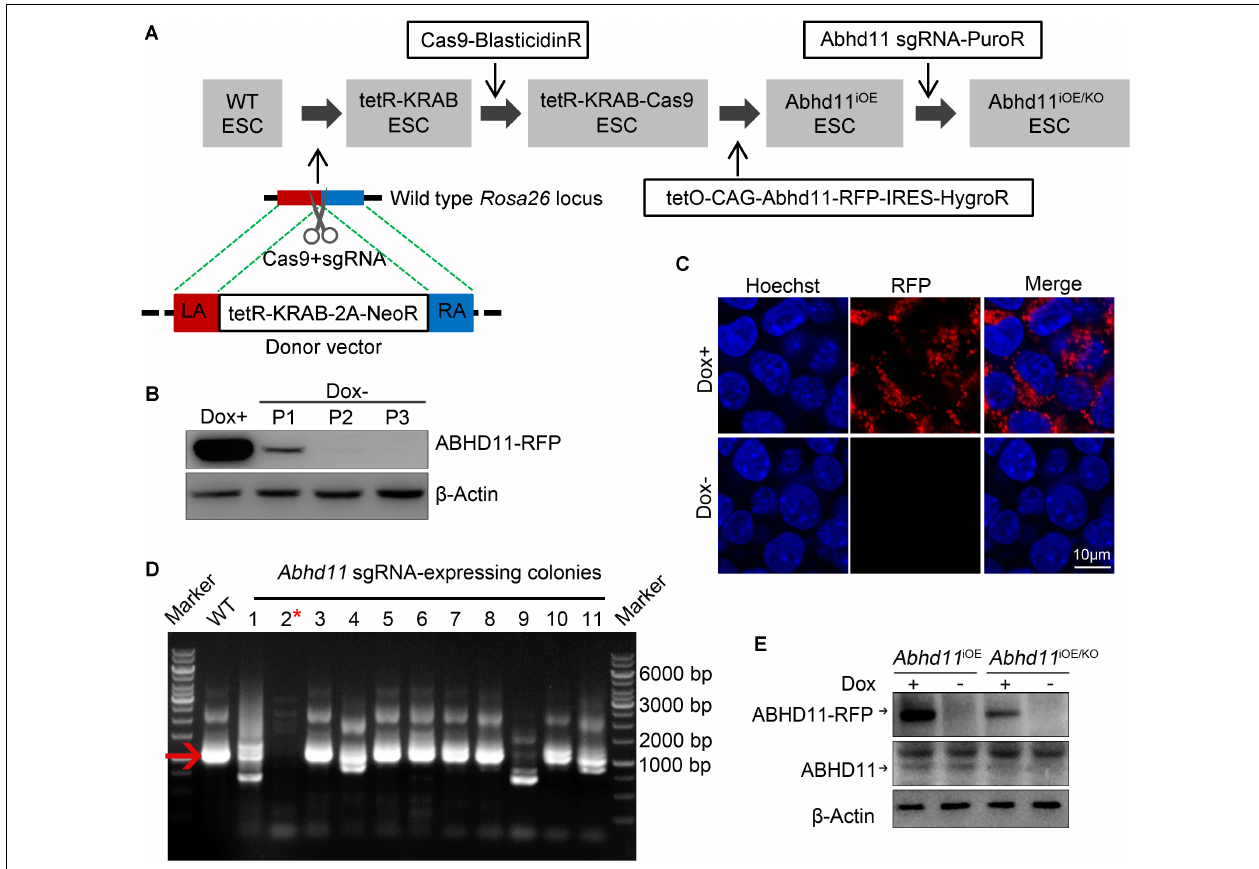
FIGURE 1 | Generation and characterization of Abhd11 iOE ESCs and Abhd11 iOE / KO ESCs. (A) Schematic illustration of the four-step strategy for generating Abhd11 iOE ESCs and Abhd11 iOE / KO ESCs. Firstly, the tetR-Krab cassette was inserted into Rosa26 locus. Secondly, lentivirus expressing Cas9 was transduced into tetR-KRAB-expressing ESCs followed by selection with blasticidin (2 µ g/ml). Thirdly, the cells were transduced with the expression cassette of tetO-CAG-Abhd11-RFP-IRES-HygroR and selected with Hygromycin (200 µ g/ml) and Dox (100 ng/ml). Finally, the Abhd11 iOE ESCs were infected with lentivirus expressing sgRNA against Abhd11 and selected using puromycin (1 µ g/ml). LA, left arm; RA, right arm. (B) Western blot analysis of the RFP expression in Abhd11 iOE ESCs cultured with Dox (1 µ g/ml) or without Dox. Cells were subjected to serial passage (P) every 2 days. β -Actin was used as a loading control. (C) Fluorescence images of Abhd11 iOE ESCs cultured with Dox (1 µ g/ml) or without Dox. After fixation, cells were counterstained with hoechst. (D) RT-PCR showing the expression of endogenous Abhd11 mRNA in wild-type (WT) ESCs and Abhd11 sgRNA-expressing colonies. The red arrow indicates the specific RT-PCR product (1002 bp) of the endogenous Abhd11 mRNA. The red asterisk refers to a colony in which the endogenous Abhd11 gene was knocked out. (E) Western blot analysis of ABHD11 using anti-ABHD11 antibody. Abhd11 iOE ESCs were cultured in the presence of 1 µ g/ml Dox or without Dox. Abhd11 iOE / KO ESCs were cultured in the presence of 1 ng/ml Dox or without Dox. β -Actin was used as a loading control.